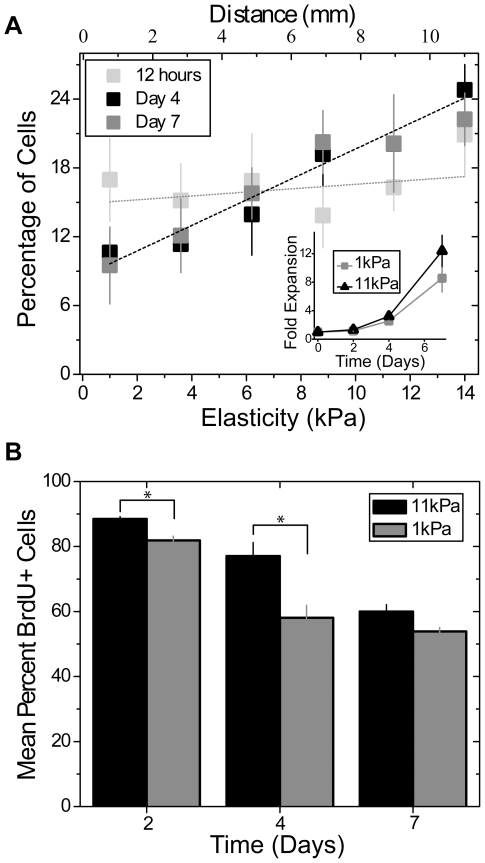
Migration and proliferation of MSCs on hydrogels.(a) At 12 hours, cell density is approximately uniform regardless of substrate stiffness (gray; p = 0.76 between data points). There was a loss and accumulation of MSCs on the softest and stiffest regions of the hydrogel, respectively, after both 4 and 7 days (p<0.005 and 0.05, respectively, using a one-way ANOVA comparison of slopes). The inset plot shows a noticeable proliferative difference in MSCs cultured on static hydrogels of 1 and 11 kPa. (b) BrdU staining of MSCs cultured on 1 or 11 kPa static hydrogels demonstrates that proliferation rate decreases as time increases for both stiffness values though MSCs on 11 kPa hydrogels proliferate at a slightly faster rate. *p<0.05 using student t-tests.